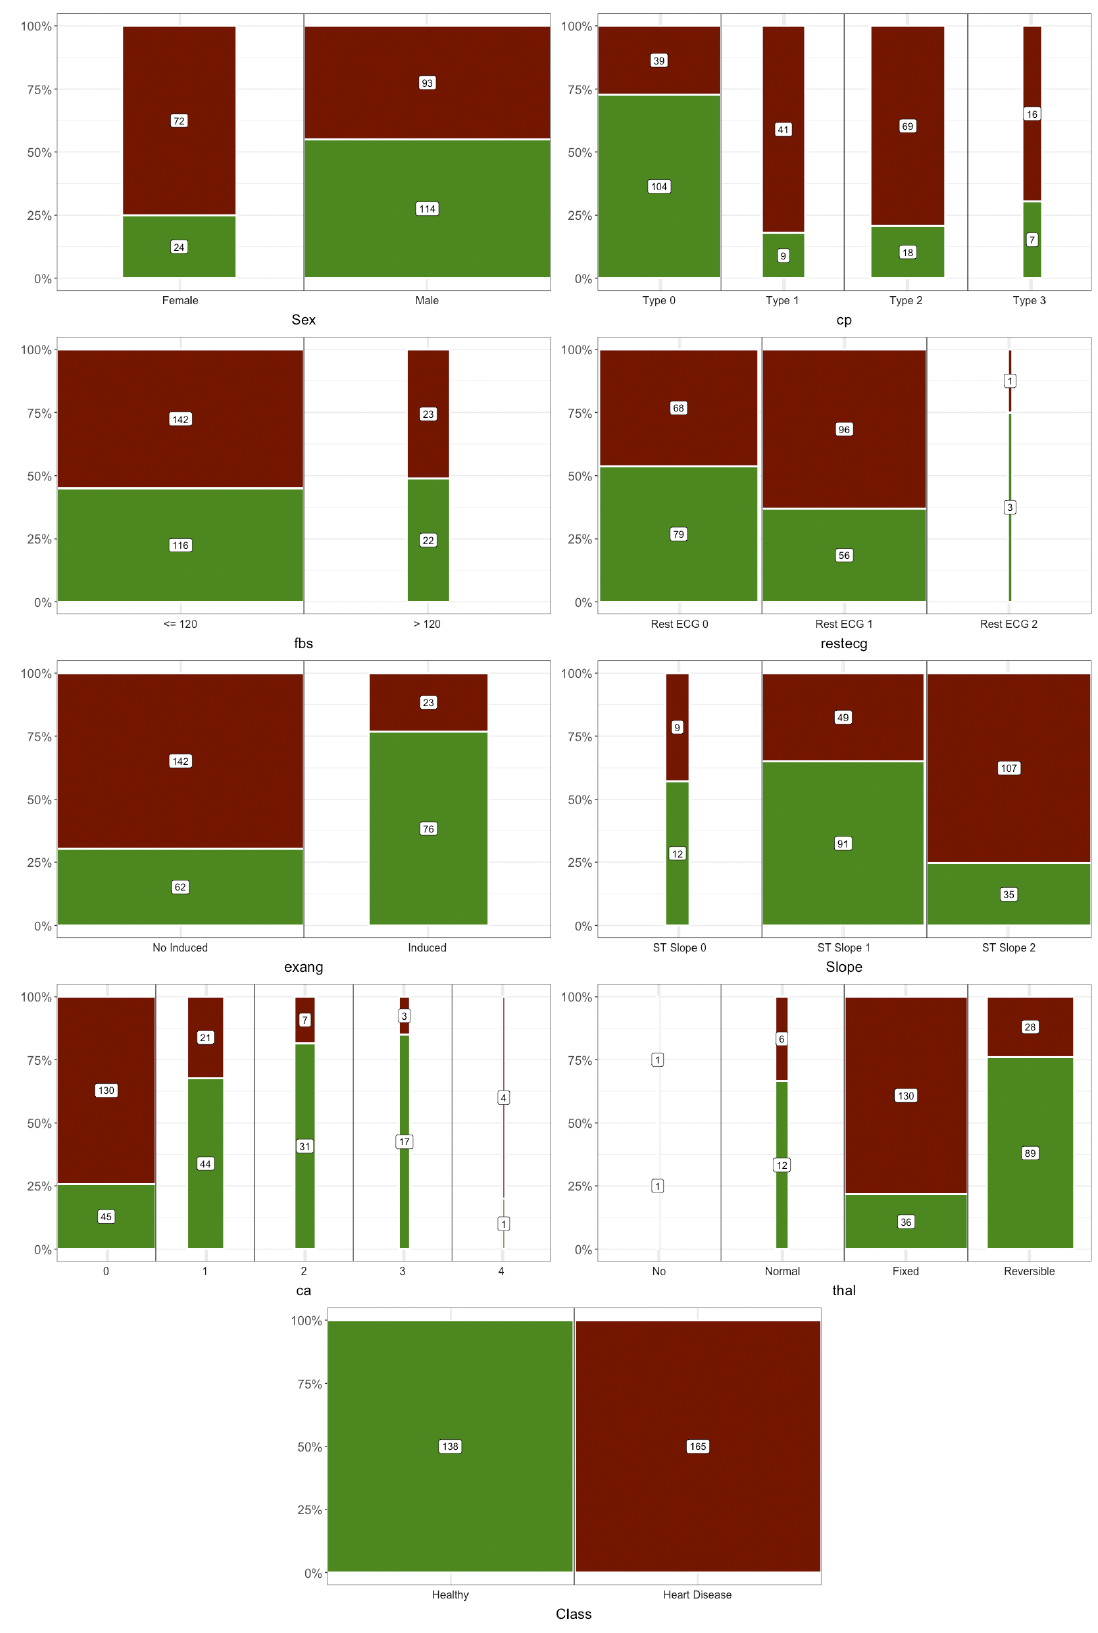
Figure 1. Mosaic plots of categorical